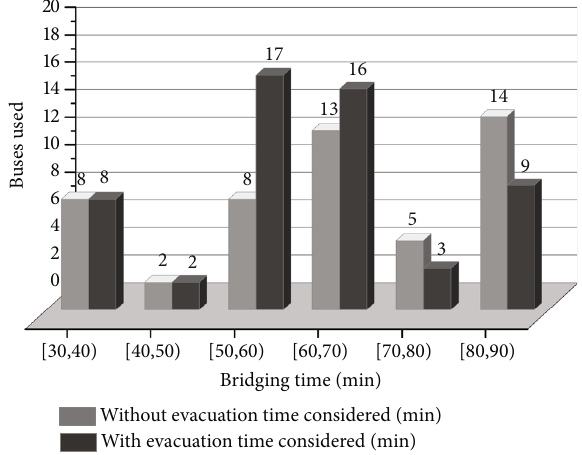
Figure 10: Bus bridging time and buses used with and without evacuation time considered.